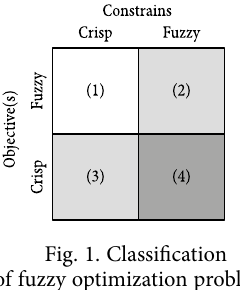
Fig. 1. Classification of fuzzy optimization problems (adopted from Leung